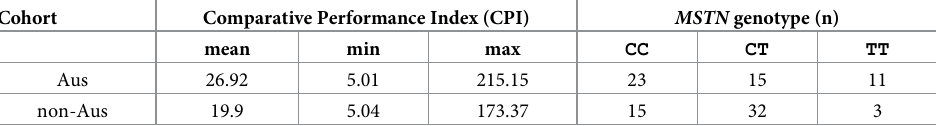
Table 3. Performance metrics and MSTN g.66493737 SNP genotypes among the comparator cohorts. All horses were elite performers. Within each cohort there was a similar MSTN genotype distribution to that observed previously within the regional population. CPI–Comparative Performance